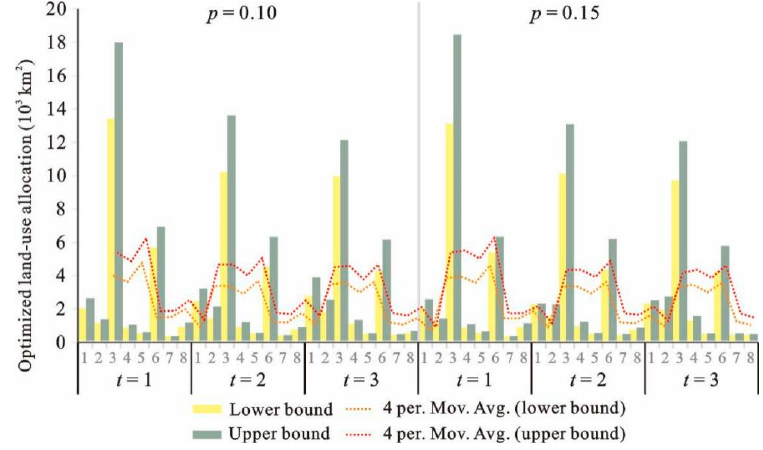
Figure 3. Optimized land-use allocation under p of 0.01 and 0.05 ( k = 1).